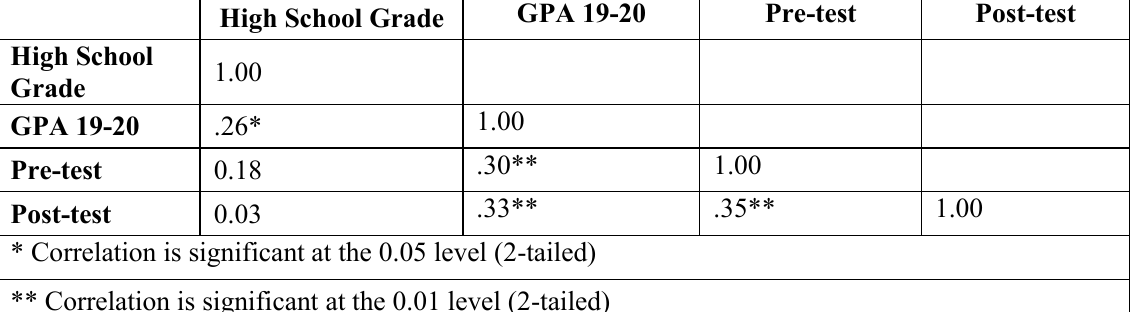
T ABLE 1. CORRELATION